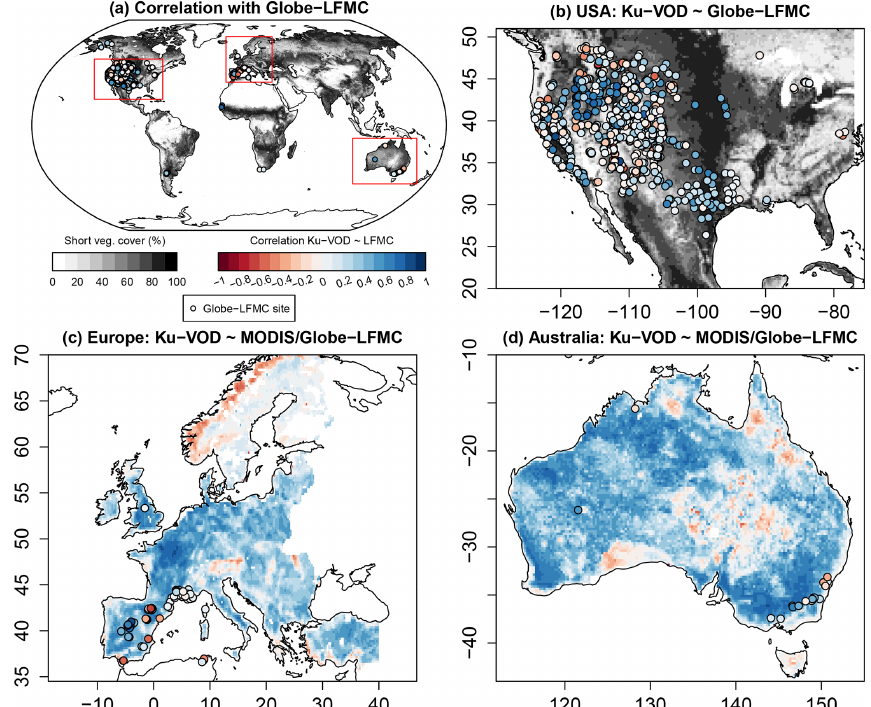
Figure 1. Temporal correlations between Ku-VOD and LFMC. Correlations of Ku-VOD with Globe-LFMC sites are plotted as point symbols and with MODIS-LFMC as coloured back ground raster (in c and d ). The greyscale raster in (a) and (b) shows percentage of short vegetation